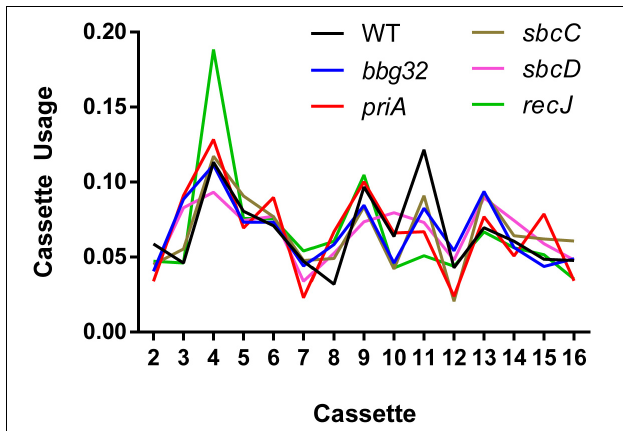
FIGURE 4 | Cassette usage for inferred recombination tracts. For each inferred recombination event, we identified the most likely originating cassette(s). The plot shows the relative usage of each silent cassette as a proportion compared to other cassettes for each mutant strain. Recombination events having N possible origins were spread out over all possible silent cassettes with a weight of 1/ N . The mutL gene disruption was omitted due to low switching activity resulting in a small sample size of only 11 recombination events.